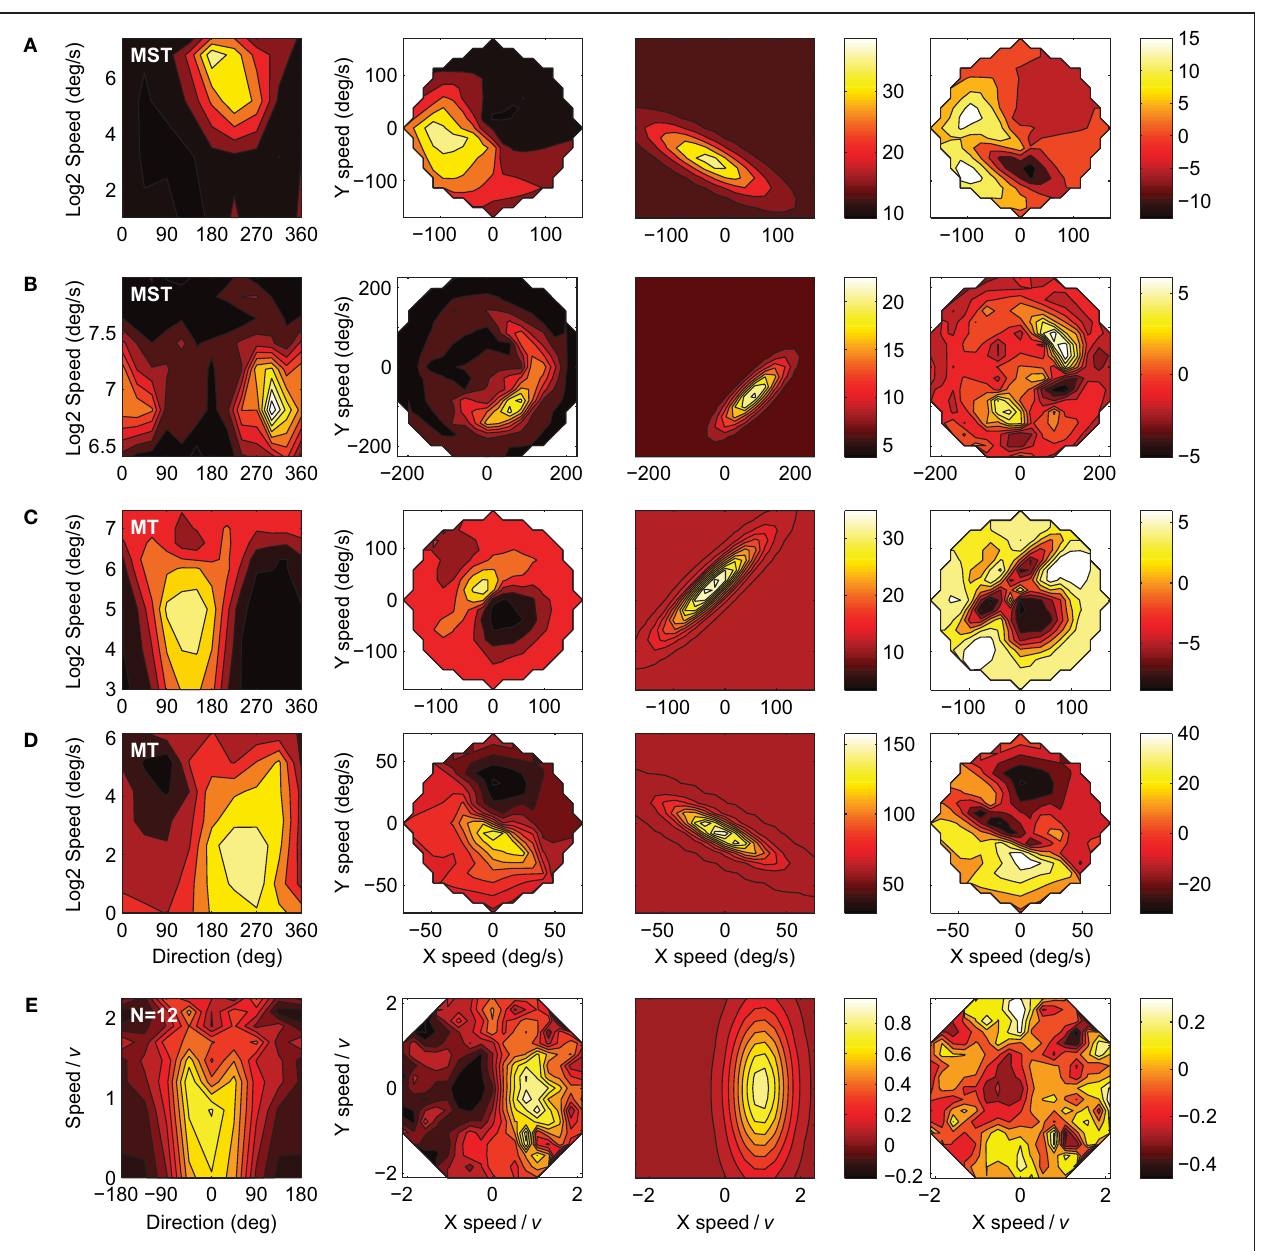
r 2 = 0 . 65, d = 315, v = 112, w = 0 . 22, e = 3 . 43 ± 1.03, a = 16, b = 6. (C) Monkey-F MT unit: r 2 = 0 . 52, d = 134, v = 35 . 9, w = 0 . 50, e = 4 . 57 ± 1.62, a = 23, b = 12. (D) Monkey-A MT unit: r 2 = 0 . 71, d = 243, v = 8 . 43, w = 0 . 80, e = 4 . 38 ± 2.55, a = 98, b = 60. (E) Pooled and normalized population mean of the 12 units. r 2 = 0 . 58, d = − 0 . 53 ± 4 . 78, v = 0 . 95 ± 0.07, w = 0 . 58 ± 0 . 10, a = 0 . 81 ± 0 . 11, b = 0 . 05 ± 0 . 04, and e = 2 . 55 ± 0 . 57. Error ranges are 95% confidence